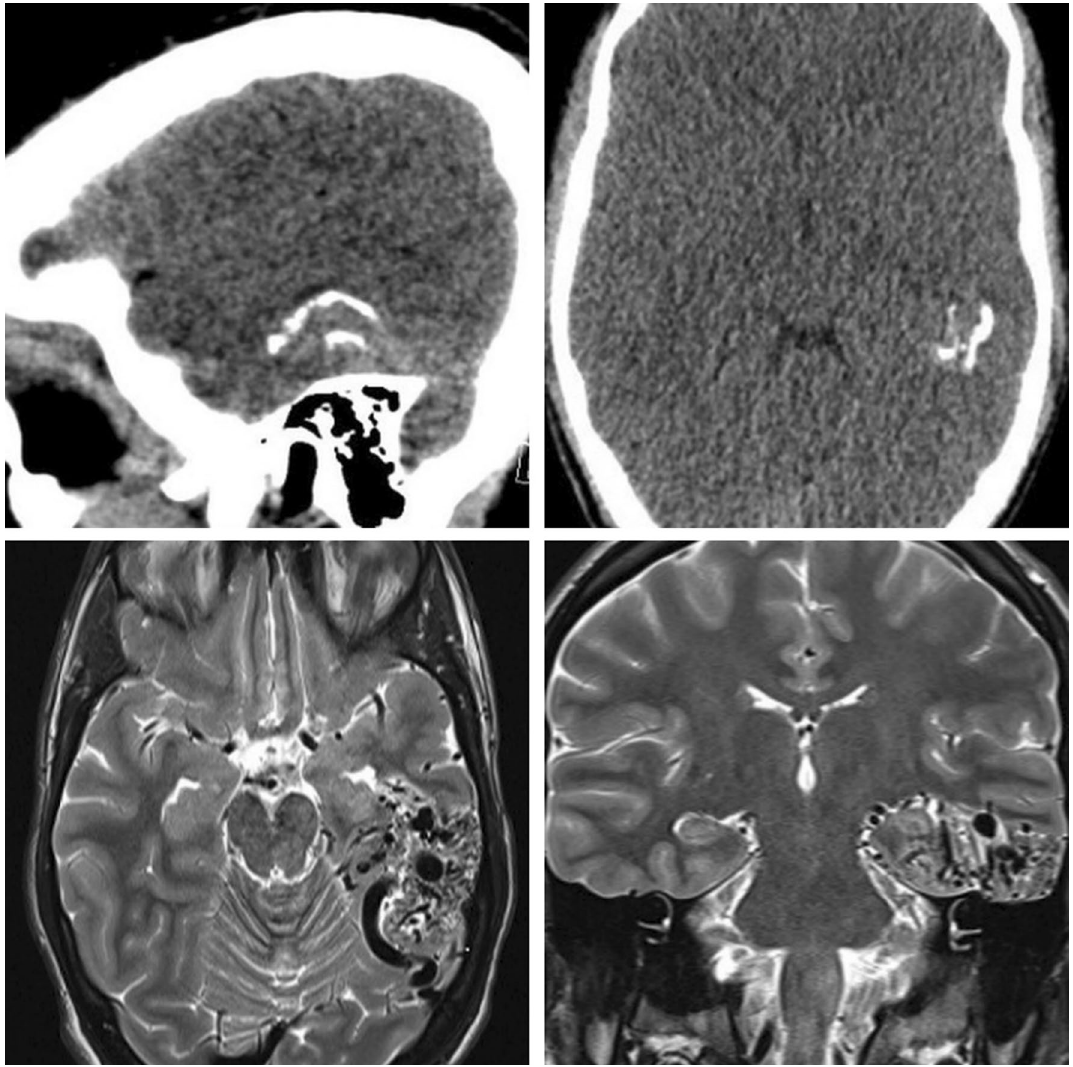
Fig. 1 Images showing the temporal, left-sided AVM in initial soft-tissue CT in sagittal (upper level, left) and in axial (upper level, right) and coronal (lower level, left) in T2-MRI with Gadolinium (GD)